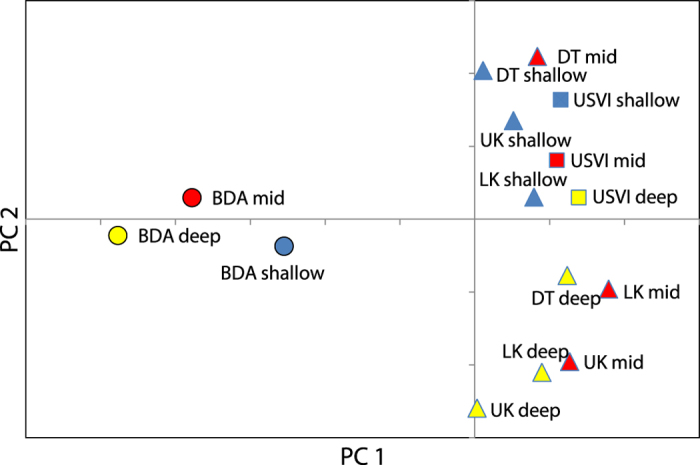
Principal Component Analysis (PCA) of allele frequency covariance in Porites astreoides populations.14 of 79 axes were retained, explaining 100% of the cumulative variance. Plotted are the first and second axes explaining 38.59% (P < 0.01) and 21.28% (P < 0.05) of the variance, respectively. Axes cross at 0. The different shapes denote each of the 3 geographic locations sampled in this study (Florida, Bermuda and U.S. Virgin Islands), whereas different colors denote each of the 3 depths under comparison [shallow (≤10 m), mid (15–20 m) and deep (≥25 m)]. UK = Upper Keys, LK = Lower Keys, DT = Dry Tortugas, Bermuda = Bermuda and USVI = U.S. Virgin Islands.